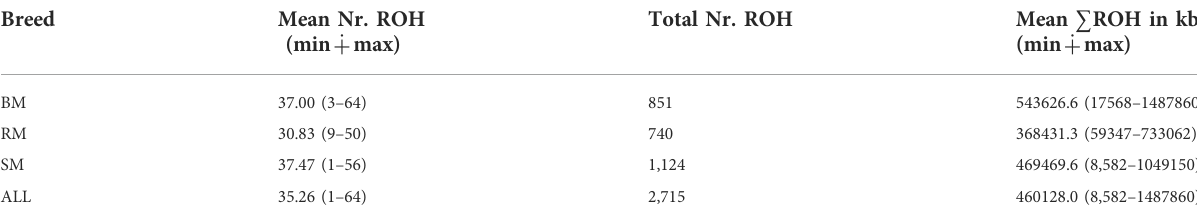
TABLE 2 The average and total number of ROHs, and average sum of ROH length in BM, RM, SM and across all three breeds (ALL). Minimum and maximum values are provided in brackets. Breed Mean Nr. ROH Total Nr. ROH Mean (cid:1) ROH in kb (min F max) (min F